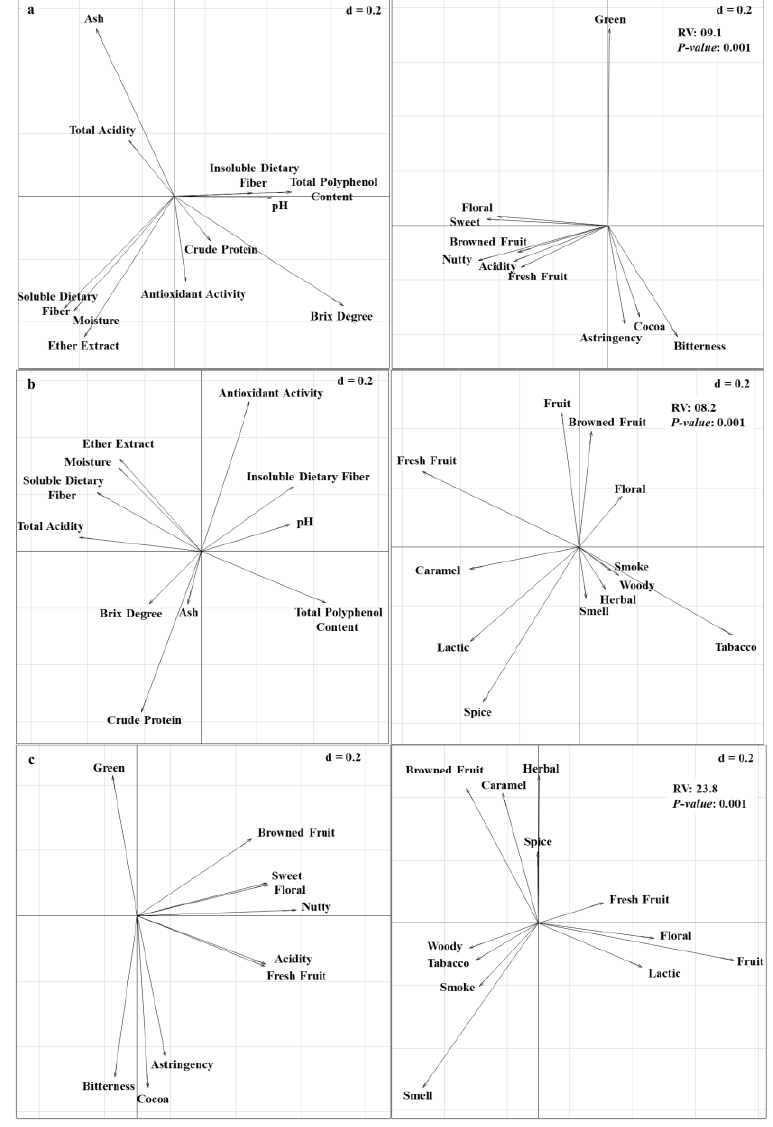
Figure 4. Co-inertia analysis of the relationship between the matrix of physicochemical variables and sensory attributes (organoleptic qualities and sensory notes) of cocoa samples from the department of Meta, Colombia. ( a ) relationship between the matrix of physicochemical variables and the matrix of sensory attributes of beans, ( b ) relationship between the matrix of physicochemical variables and positive-negative cocoa notes of cocoa samples, ( c ) relationship between the matrix of sensory profile and positive-negative cocoa notes of cocoa samples.